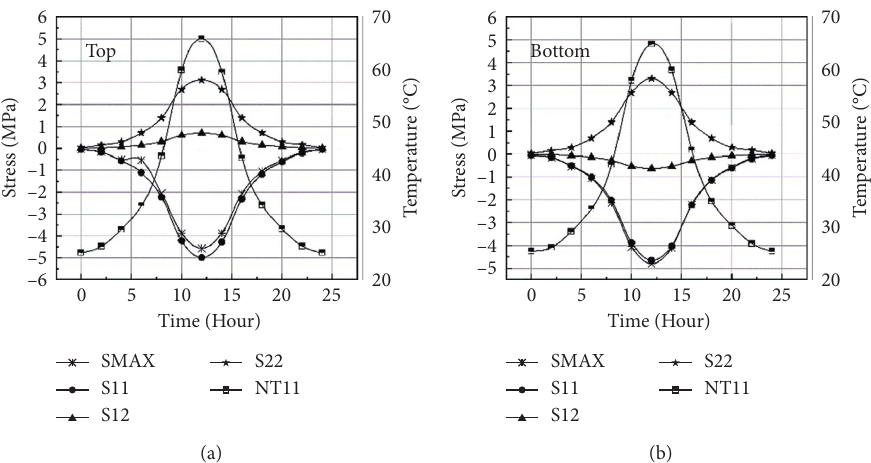
Figure 6: Time-history response curve of stresses above void area in the “normal” condition in the summer: (a) slab top and (b) slab bottom.